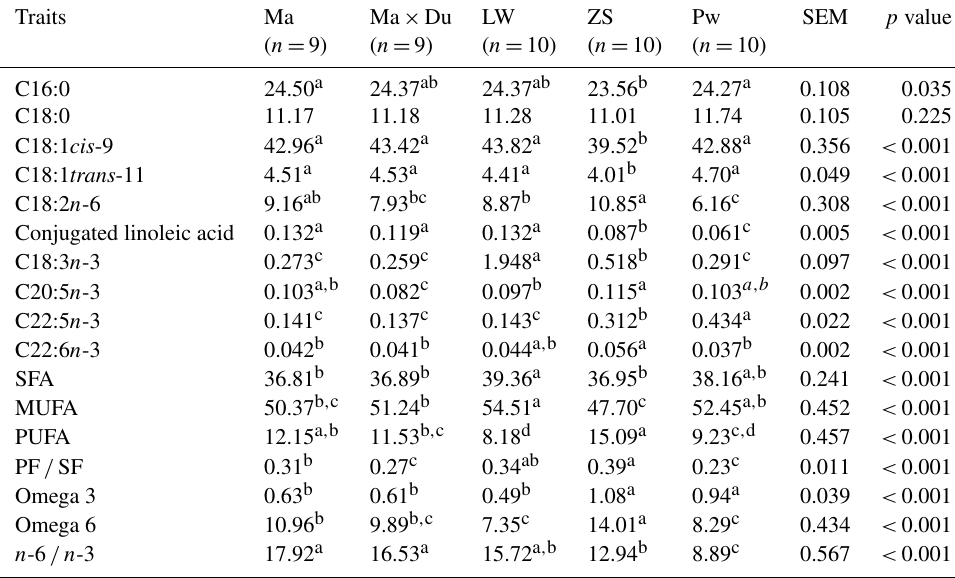
Table 8. Fatty acid composition of total intramuscular fat of Musculus longissimus dorsi from various genotypes.